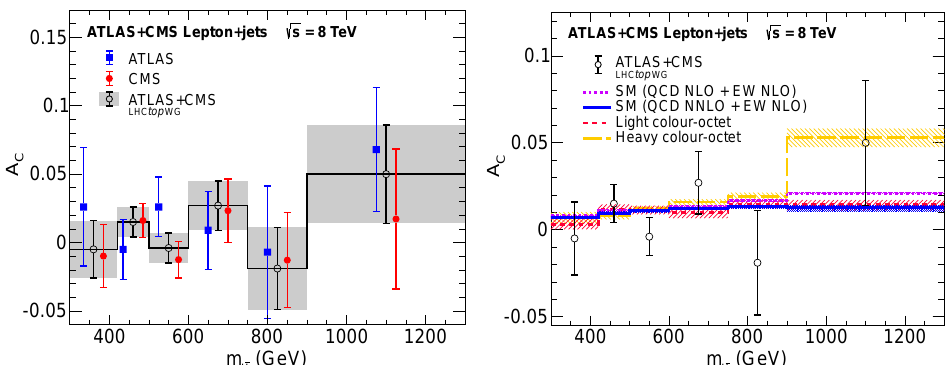
Figure 22. A t ¯ t results as a function of the invariant mass of the t ¯ t system by ATLAS, CMS, and the C LHC combined value ( left ). The LHC combined A t ¯ t as a function of the invariant mass of the t ¯ t C system compared to two calculations for the SM and to calculations for a colour octet model for two different mass scales